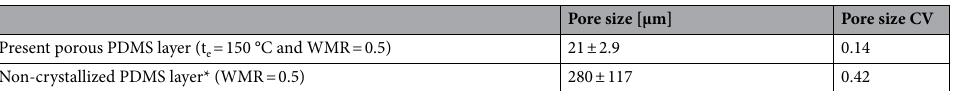
Pore size [µm] Pore size CV Present porous PDMS layer (t e = 150 °C and WMR = 0.5) 21 ± 2.9 0.14 Non-crystallized PDMS layer* (WMR = Table 3. Pore size and CV of the present and the non-crystallized porous PDMS layer. *Non-crystallized porous PDMS layer is fabricated by mixing PDMS and citric acid without crystallization.